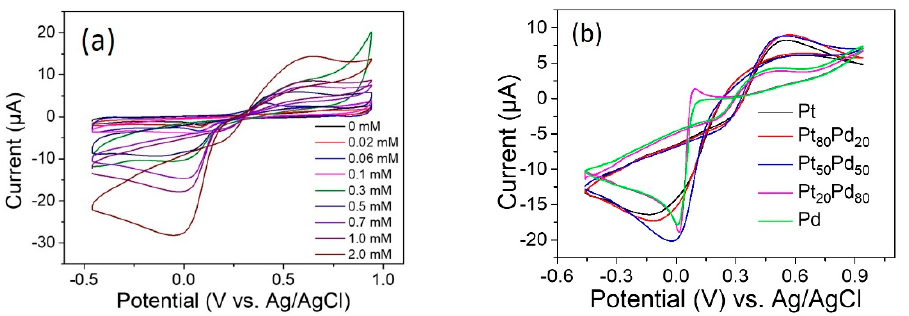
Figure 4. ( a ) CV curves of Pt 50 Pd 50 aerogel modified GCE at concentrations of 0, 0.02, 0.06, 0.1, 0.3, 0.5, 0.7, 1.0, and 2.0 mM H 2 O 2 in N 2 -saturated 0.1 M phosphate buffer saline (PBS). ( b ) CV curves of bimetallic aerogels and monometallic aerogel modified GCEs at a concentration of 1.0 mM H 2 O 2 in N 2 -saturated 0.1 M PBS. Potential range: − 0.64-0.96 V vs. Ag/AgCl. Scan rate: 50 mV s − 1